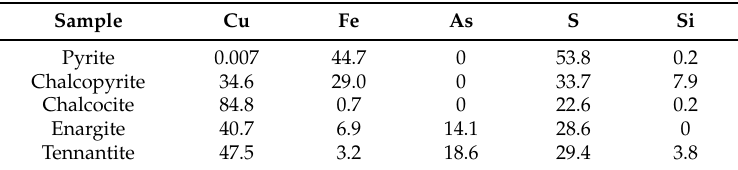
Table 1. Chemical composition of each sample